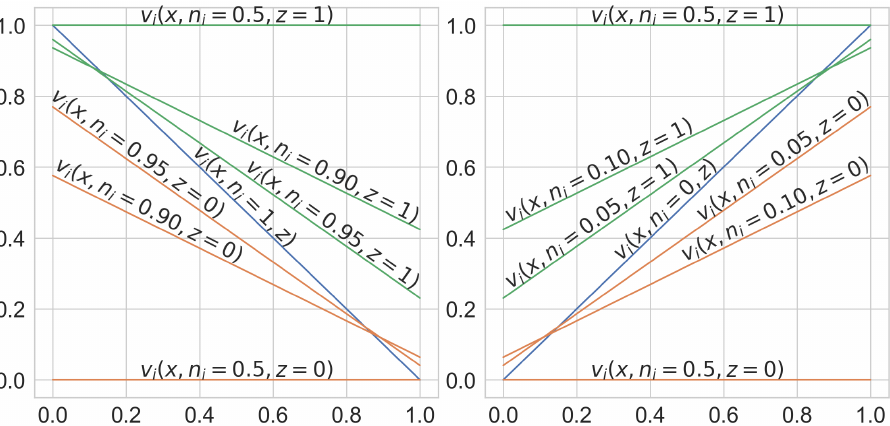
Figure 2. Sample transformations of input variables for control parameters ( left ) n ≥ n mean (“nega- tion” mode); ( right ) n ≤ n mean (“passthrough” mode).